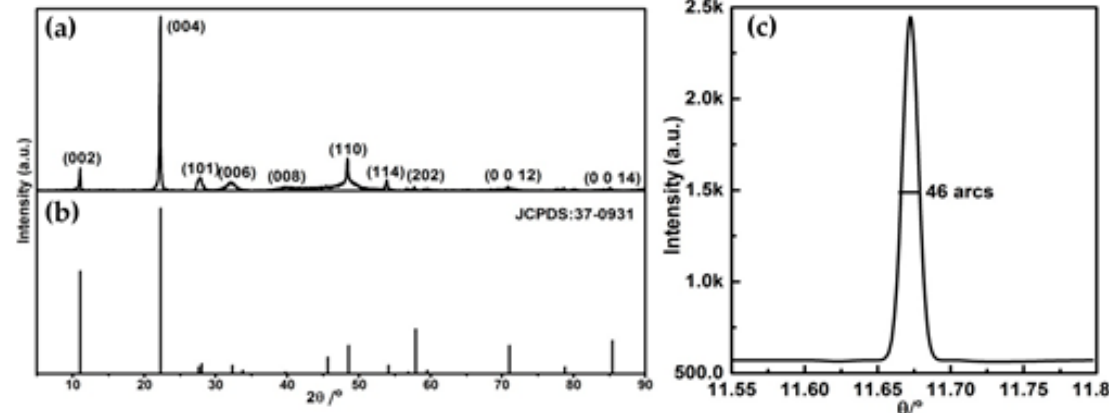
Figure 2. ( a ) The powder X-ray diffraction pattern (GaSe) of GaSe sample; ( b ) the PDF database of GaSe (JCPDS: 37-0931); and ( c ) the rocking curve of the (004) face.